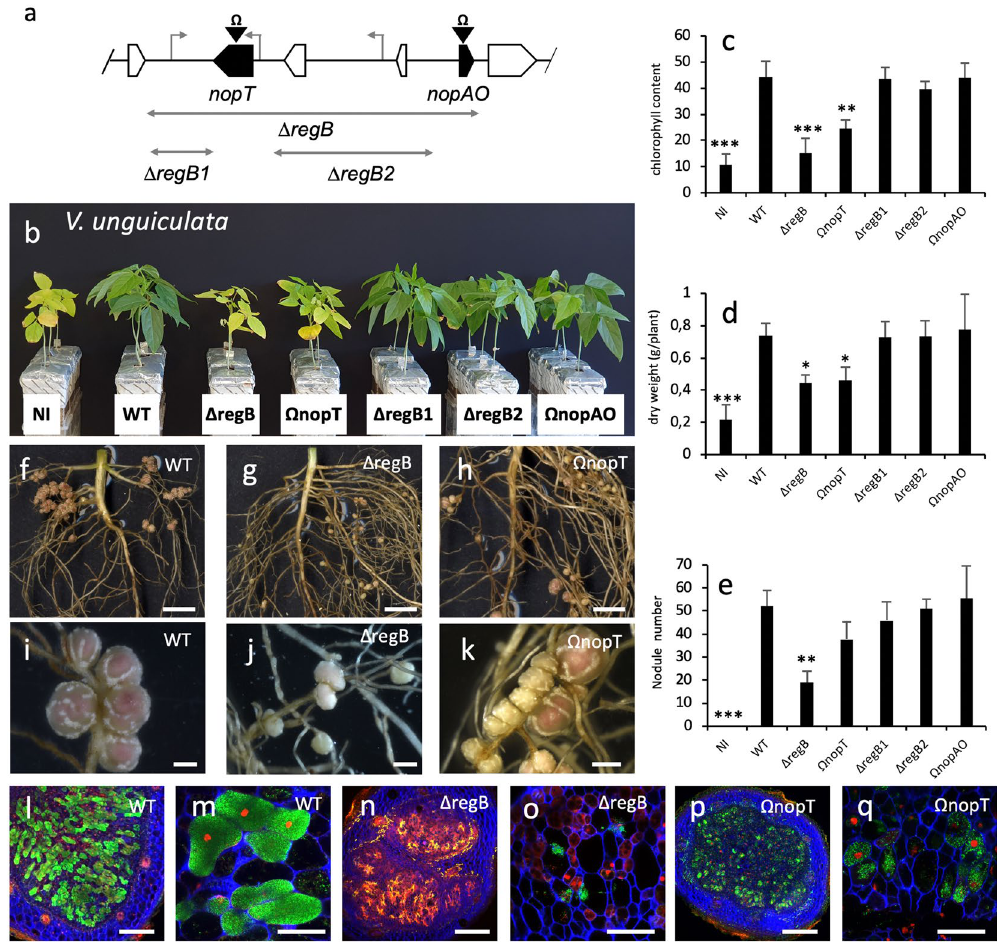
Figure 3. Symbiotic properties on V. unguiculata of the ORS3257 mutants in the different effectors and the regions encompassing the tts boxes identified in region B. ( a ) Genetic organisation of the putative effectors and tts boxes identified in region B. The deleted regions in the mutants are indicated by double direction arrows. The insertion mutants are indicated by black arrowheads carrying the Ω sign. In black, putative effector genes; gray arrows, tts boxes. ( b ) Comparison of the growth of the plants (aerial part), non-inoculated (NI) or inoculated with ORS3257 wild-type strain (WT) or its derivative mutants at 21 days after inoculation. ( c ) Leaf chlorophyll content. ( d ) Plant dry weight; ( e ) Number of nodules per plant. The experiment was carried out in duplicate with five plants per condition. *P < 0.05, **P < 0.01, and ***P < 0.001, significant differences between WT ORS3257 and its derivative mutants using a nonparametric Kruskal–Wallis test. ( f – k ) View of the root and the nodules induced by strain ORS3257 and its derivative mutants. (Scale bars: f to h, 1 cm; i to k, 2 mm). ( l – q ) Cytological analysis of the nodules induced by strain ORS3257 and its derivative mutants observed by confocal microscopy after staining with SYTO 9 (green: live bacteria), calcofluor (blue: plant cell wall), and propidium iodide (red: infected plant nuclei and dead bacteria or bacteria with compromised membranes). (Scale bars, l, n, p, 200 µm; m, o, q, 50